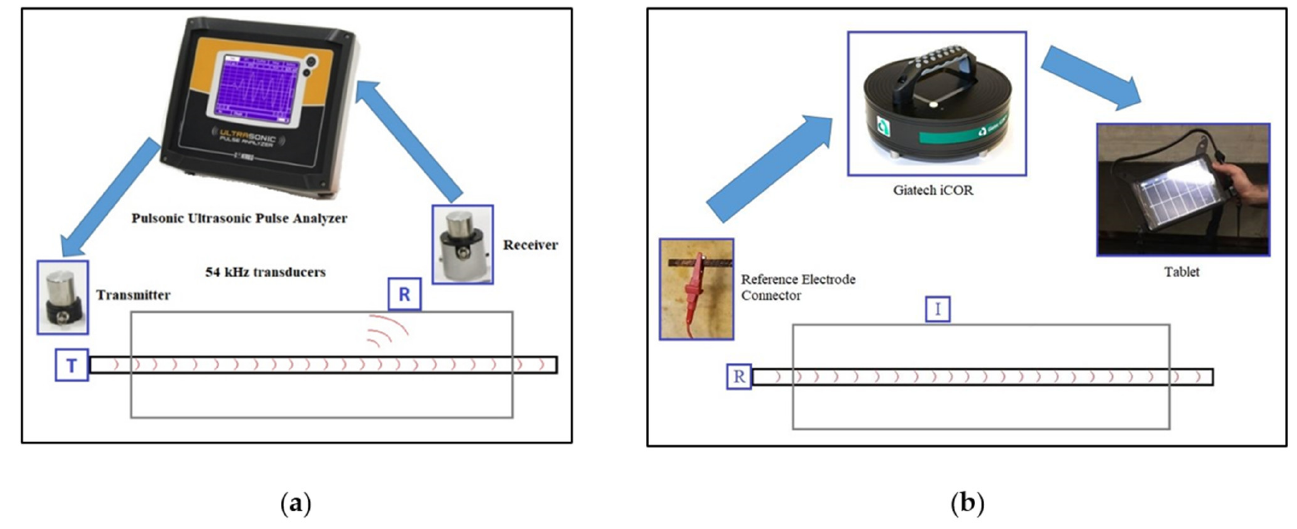
Figure 1. Experimental set-up: ( a ) UGWL; ( b ) HCP.